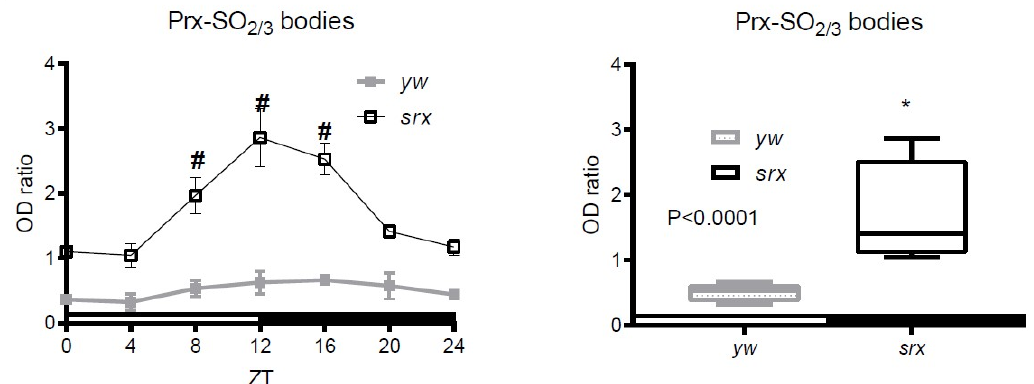
Figure 4. Analysis of of daily changes in peroxiredoxin hyperoxidation in the srx mutant. Samples were prepared from 5 da old control ( yw ) and srx mutant (srx). Flies were reared under LD conditions and collected at 4 h intervals. Immunoblots were performed under reducing conditions and developed with an antibody that recognizes Prx-SO 2/3 forms and re-probed with anti-actin antibodies to control for loading. The results are mean ± SEM ( n = 3). In the graphs shown on the left, # marks statistically significant differences between ZT0 and ZT4–24. In the graphs shown on the right, * marks a significant difference between 5 da and 50 da flies. Representative immunoblot images are shown in Figure S6.